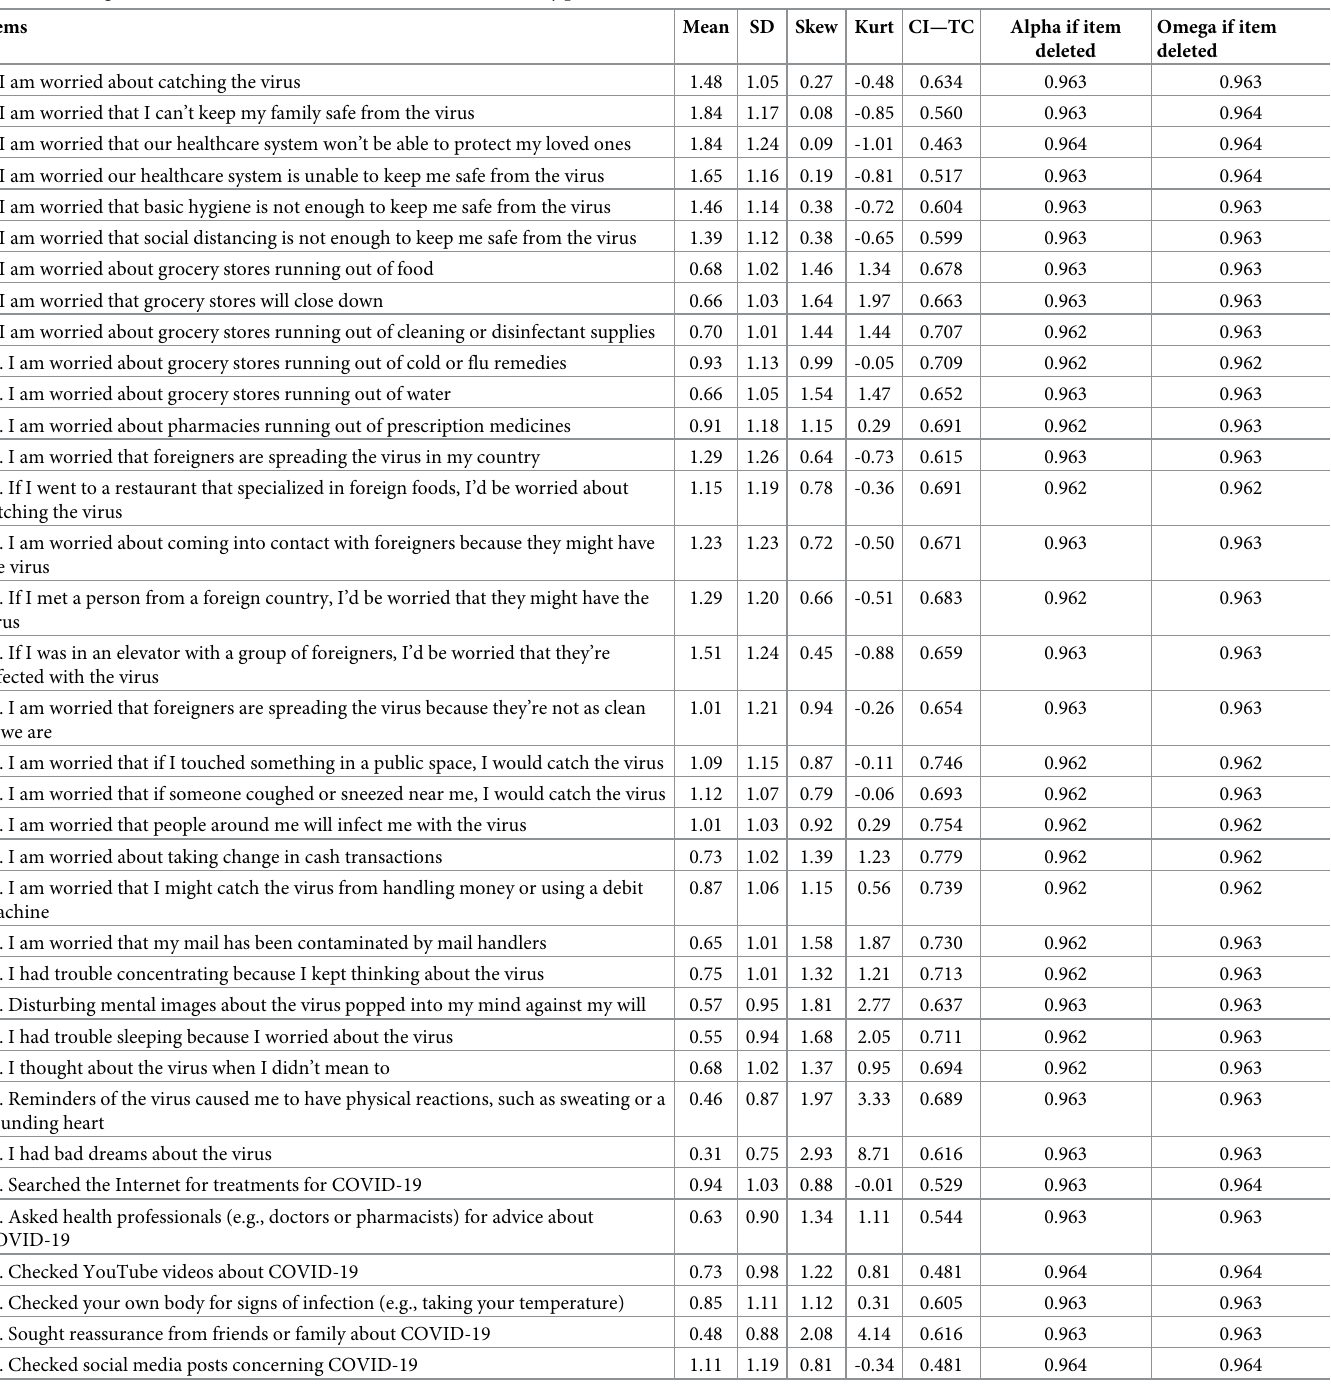
Table 1. Average COVID Stress Scales item scores and their reliability